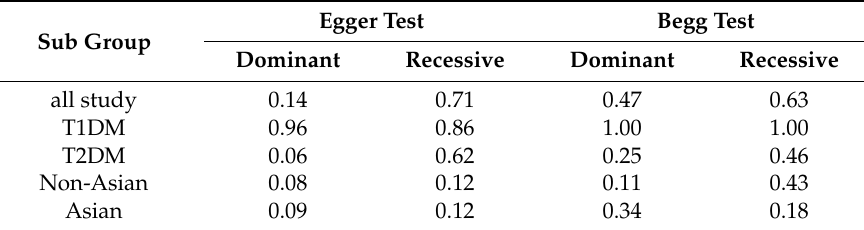
Figure 3. Evaluation of publication bias using funnel plots. Plots are shown for all studies. Table 4. The results of publication bias test by Egger and Begg test.